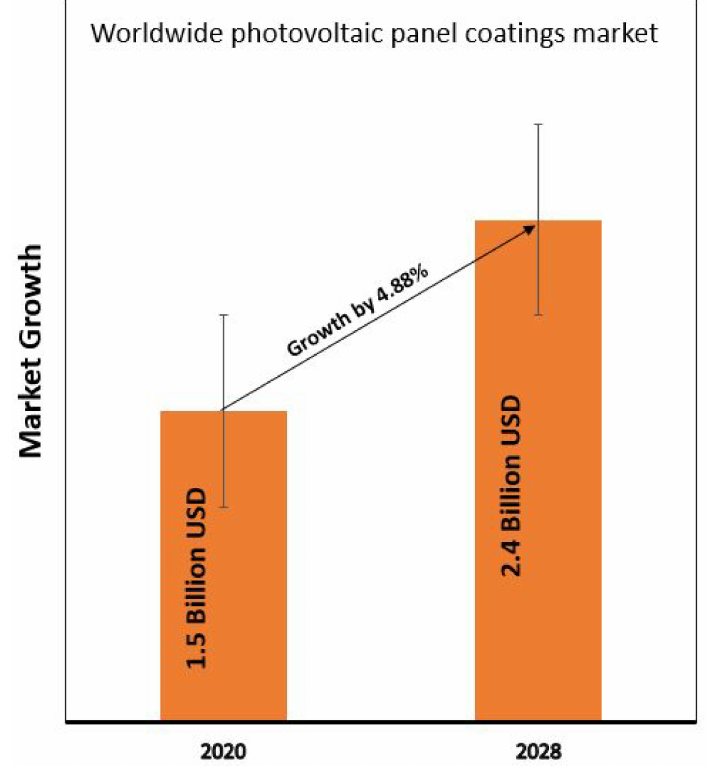
Figure 15. Global solar panel coating market, adapted from